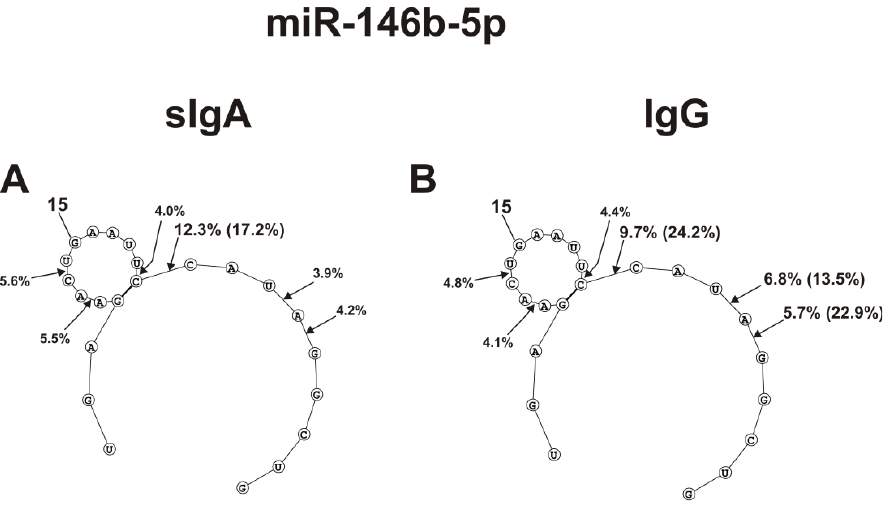
Figure 6. The average efficiencies of Flu-miR-146b-5p ( A , B ) hydrolyzed by seven sIgAs ( A ) and IgGs ( B ) from human milk plasma, in all sites of their cleavage. The average percentages of microRNAs and cleavage positions in different microRNA hydrolysis sites by antibodies are shown using spatial models of microRNAs. Values in parentheses indicate the efficiencies of microRNA hydrolysis at individual sites by some preparations, with an increased specific activity in relation to these sites. Number 15 corresponds to the nucleotide of the central part of the RNA loop.